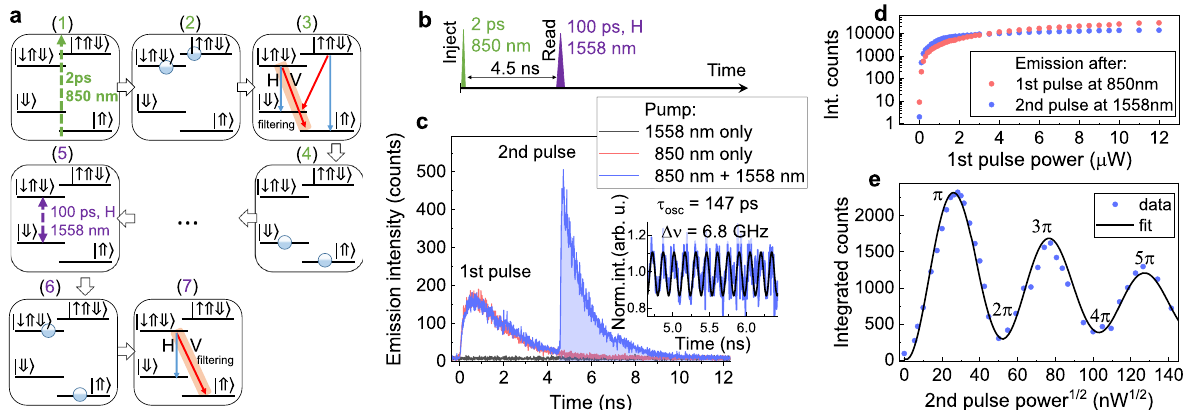
Fig. 2 Charge injection and coherent control of trion state. a Schematic description of optical charge injection (1 – 4) and coherent control of trion state (5 – 7) used in the experiment. First, (1) a nonresonant pulse excites carriers in the semiconductor which then relax (2) forming a trion state with random (cid:1) (cid:1) (cid:3) (cid:3) (cid:1) (cid:1) state. (5) The second pulse at H or * spin-con fi guration. Next, (3) the trion recombines radiatively (4) leaving the QD with a charge in a random + (cid:1) (cid:1) (cid:1) (cid:3) (cid:3) (cid:3) (cid:1) (cid:1) (cid:1) polarization resonant with + - #*+ transition excites the system into (6) #*+ trion state which can then recombine radiatively emitting an H or (cid:1) (cid:1) (cid:3) (cid:3) (cid:1) (cid:1) transition is fi ltered spectrally and detected. b The excitation pulse sequence used in the - * V-polarized photon. In the experiment the V-polarized #*+ (cid:1) (cid:3) (cid:1) experiment. The fi rst pulse at 850 nm injects the carrier into the QD and a second pulse at 1558 nm resonantly excites the system into the #*+ state. (cid:1) (cid:1) (cid:3) (cid:3) (cid:1) (cid:1) emission after nonresonant pulse only (red curve), resonant pulse only (black curve) and both pulses (blue curve). Emission - * c Time-trace of #*+ (cid:1) (cid:1) (cid:3) (cid:3) (cid:1) (cid:1) after resonant pulse exhibits slight amplitude oscillations with a period of 147 ± 1 ps corresponding to the #*+ - "*+ states splitting. Inset: Intensity oscillations recovered from the time-trace. d Integrated emission counts after 1st (nonresonant) and 2nd (resonant) excitation pulse in the function of 1st (nonresonant) pulse power. e Integrated emission counts after 2nd (resonant) pulse in the function of the square root of the 2nd (resonant) pulse power. The emission exhibits clear Rabi oscillations up to 5 π pulse (cid:1) (cid:1) (cid:3) (cid:3) (cid:1) (cid:1) states. Access to any and * pole represent the pure + arbitrary Bloch vector on the sphere requires the ability of spin rotation along two perpendicular axes to control both θ and ϕ angle.